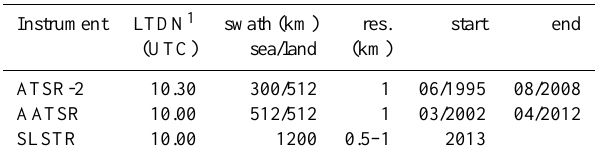
Table 2. ATSR instrument specifications. Note that for SLSTR the numbers specified are provisional as the instrument is still in the design phase. The swath width for SLSTR is the width of the dual view swath, the single view swath will be